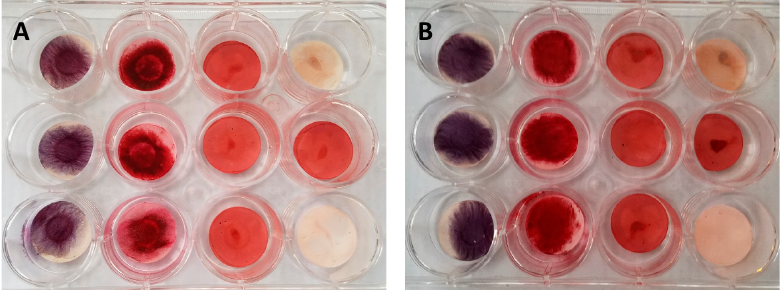
Figure 9. Results of 21-day differentiation assay of GMSCs; Panel A —dGMSCs and Panel B —hGMSCs. The setup outlined in Figure 1 was followed in these experiments. The first two columns represent cells cultured in osteogenic media while the third was cultured in adipogenic media and the fourth column represents control. Columns 1, 2s and 3 were stained for alkaline phosphatase, Alizarin red, and Oil Red O, respectively. The top well in the control was stained for alkaline phosphatase, middle well for Oil Red O, and bottom well for Alizarin red. As can be seen, panel B stains more strongly for osteogenic markers compared to panel A , suggesting increased osteogenic potential for hGMSCs. Oil Red O demonstrates non-specific binding of the stain to the cell-scaffold construct.